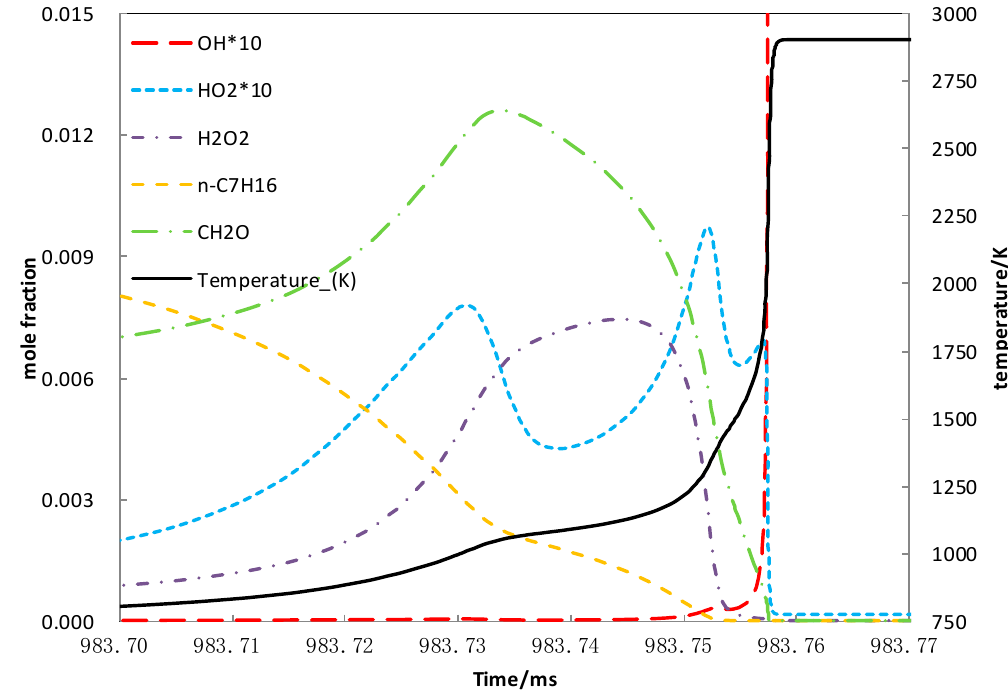
Figure 9. Mole fraction of major substances and temperature variation with